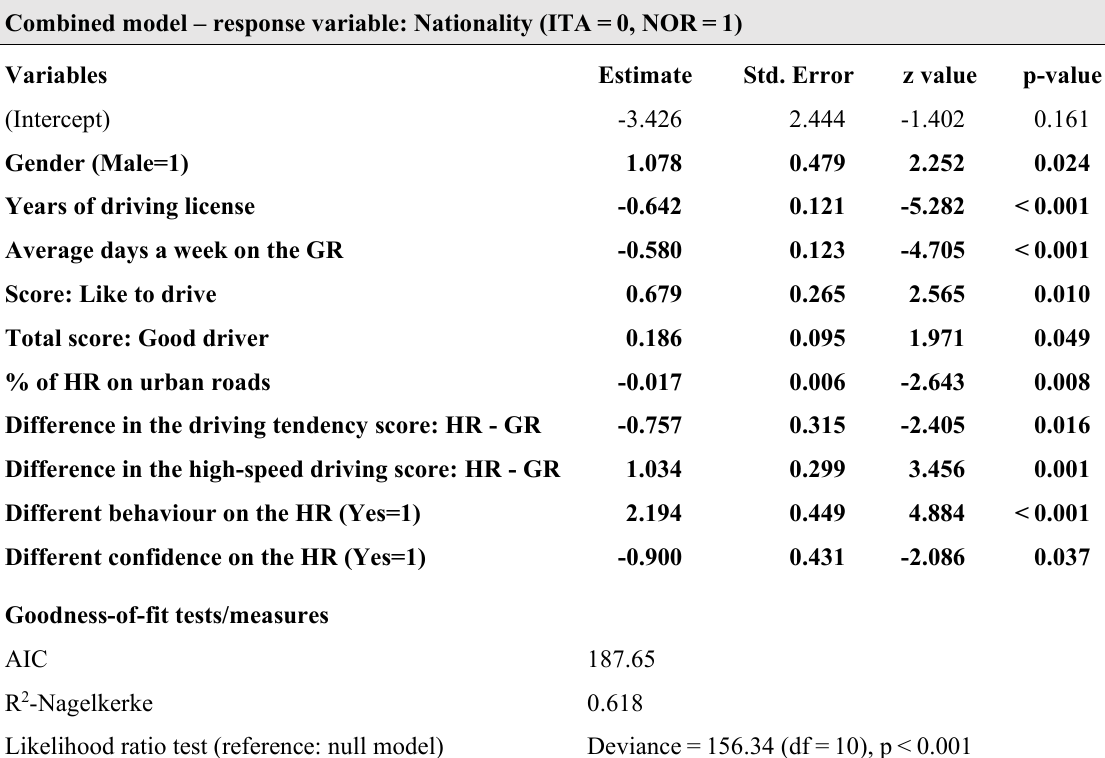
Table 4 Results from logistic regression for predicting nationality on the combined dataset Combined model – response variable: Nationality (ITA = 0, NOR = 1)